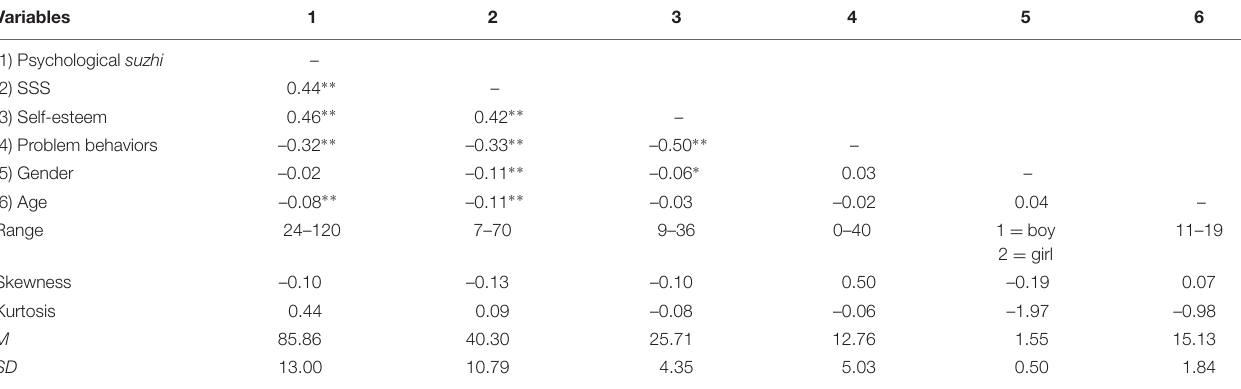
TABLE 1 | Descriptive statistics and bivariate correlations between study variables ( N = 1271). Variables